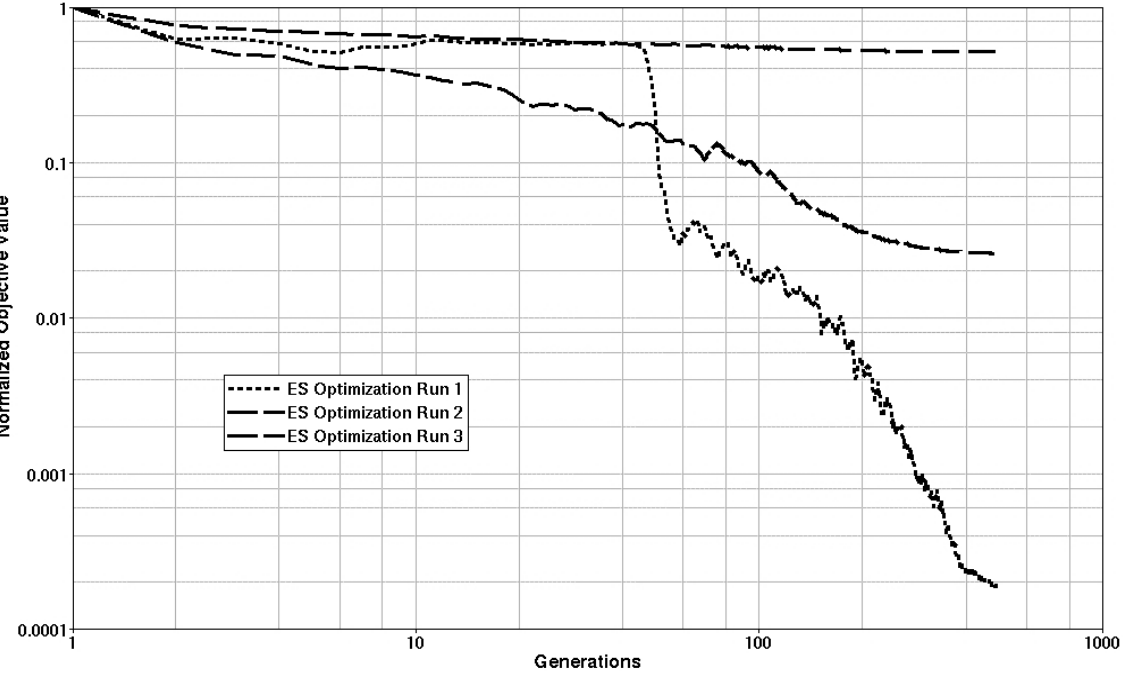
Fig. 5. Normalized objective function values are plotted against number of generations in ES optimization. Three different convergence patterns are shown here. population. Finally, it deterministically selects the best performing individuals to form the new parent